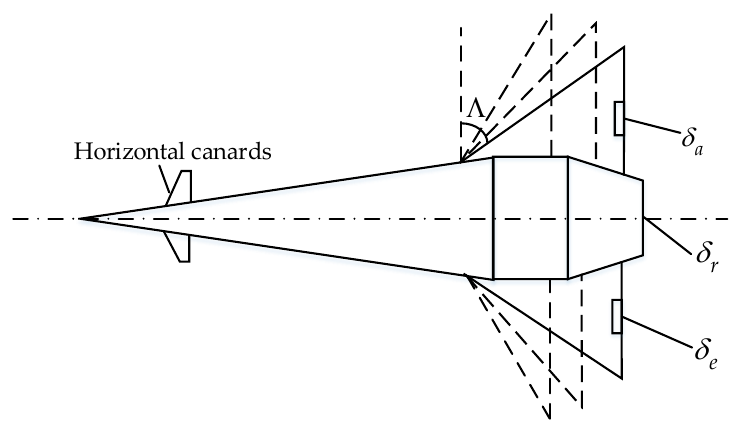
Figure 1. VSNSV aerodynamic model.